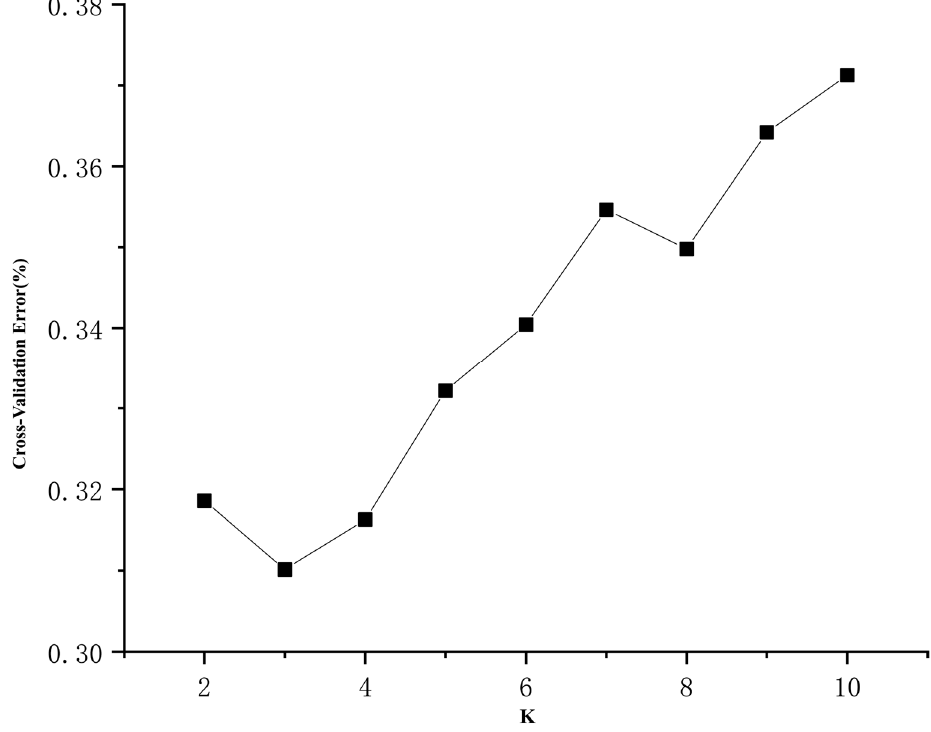
Figure 2. Cross-validation error value based on ADMIXTURE v1.23 software. The best number of clusters was 3 according to the minimum cross-validation rate.